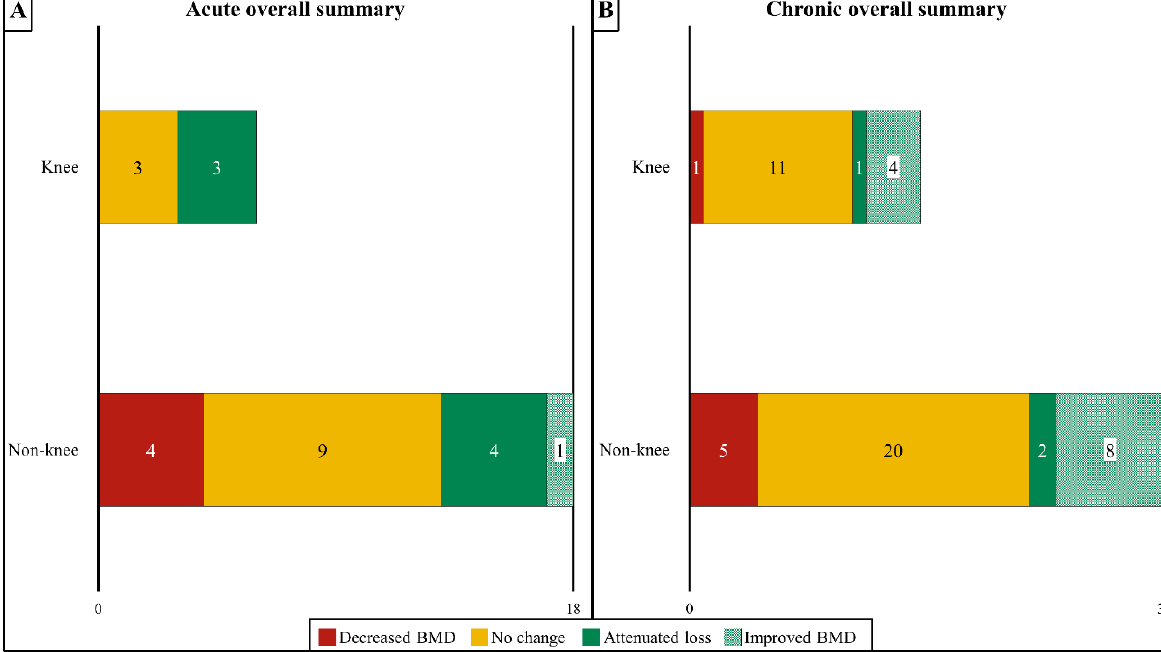
Figure 3. Summary of the effects of activity-based physical therapy (ABPT) on changes in bone mineral density (BMD) at the knee (distal femur and proximal tibia) or all other sublesional non-knee sites for persons with acute/sub-acute ( A ) or chronic ( B ) SCI in aggregate. Overall, half of all acute studies and most chronic studies showed no effect on BMD at the knee or non-knee sites. For data on specific ABPT modalities see Figure 1A,B (acute/subacute SCI) or Figure 2A,B (chronic SCI).